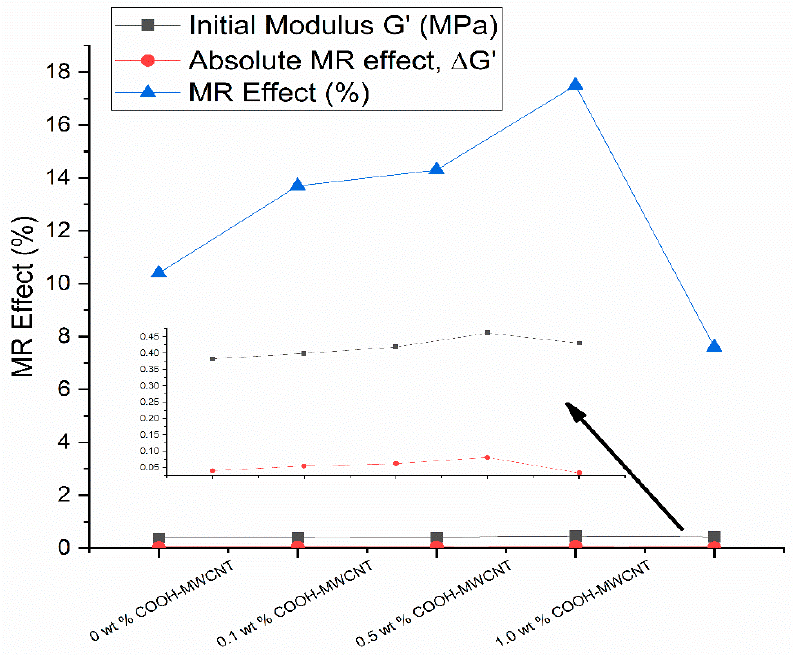
Figure 17. Viscoelastic properties of the MRE and MWCNT ‐ MRE under applied magnetic fields. ( a ) Storage modulus (G’) of MRE and MWCNT ‐ MRE. ( b ) Loss factor (Tan δ ) of MRE and MWCNT ‐ MRE.